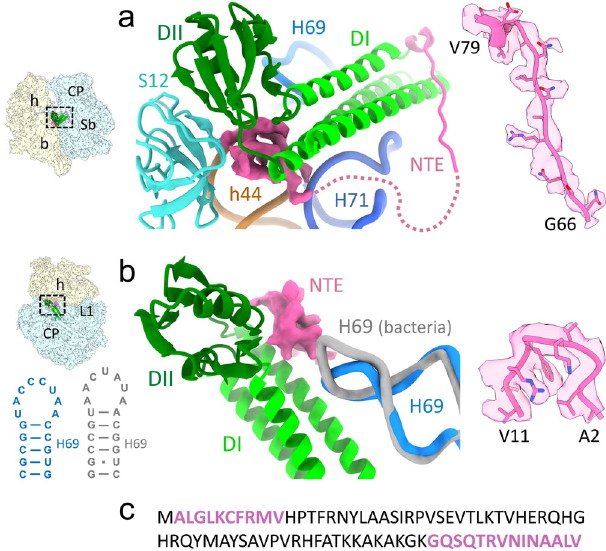
Fig. 2 Structures of two NTE segments of RRF mt . a Density corresponding to the N-terminus segment of RRF mt NTE (pink) observed in the inter- subunit space sandwiched between the 28S SSU components, including MRP uS12m (cyan) and the 12S rRNA helix h44 (brown), the 39S LSU components, including 16S rRNA helices H69 (medium blue) and H71 (dark blue), and the outer bent of the junction between domains I and II of RRF mt . The dotted line (pink) depicts the connection between two structurally stabilized segments of the RRF mt ’ s NTE. b H69 superimposition from bacterial (gray) 33 and human mitochondrial ribosomes (blue) reveals the shortening of H69 in the mitoribosome, also depicted in secondary structures of H69 on the lower left. Domain II of RRF mt interacts with the shorter H69 through its strategically positioned N-terminus of NTE (pink). c Sequence of NTE showing two modeled regions (pink). Thumbnails to the left depicts an overall orientation of the 55S mitoribosome, with semitransparent 28S (yellow) and 39S (blue) subunits, and overlaid positions of ligands. Landmarks on the thumbnail: h, head, and b, body of the 28S subunit, and CP central protuberance, Sb stalk base of the 39S